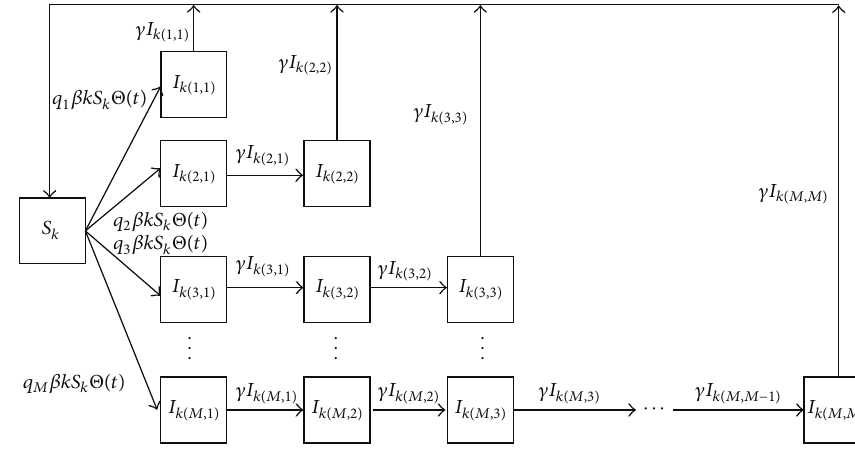
Figure 1: The flowchart of disease